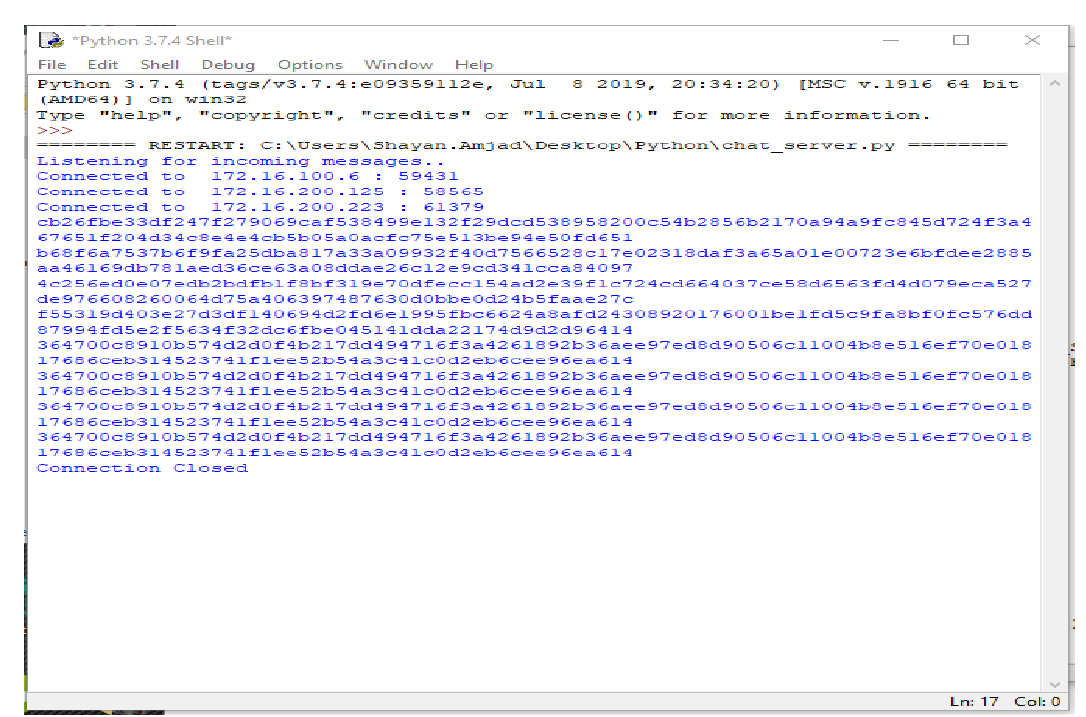
Figure 7. Hash of record entered by the new node.